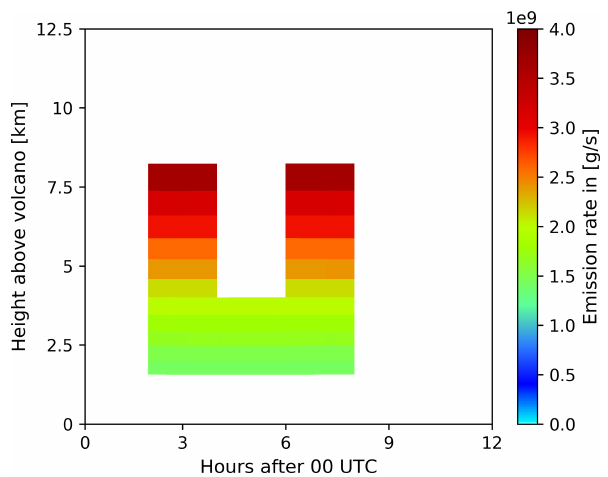
Figure 2. Hovmöller-like plot of the volcanic ash emission profile used in the nature run to generate the synthetic observations simu- lating SEVIRI-like column mass loading data for the ESIAS-chem system tests. Shown is the emission rate (colored) for a given time ( x axis) and height above the volcano ( y axis).